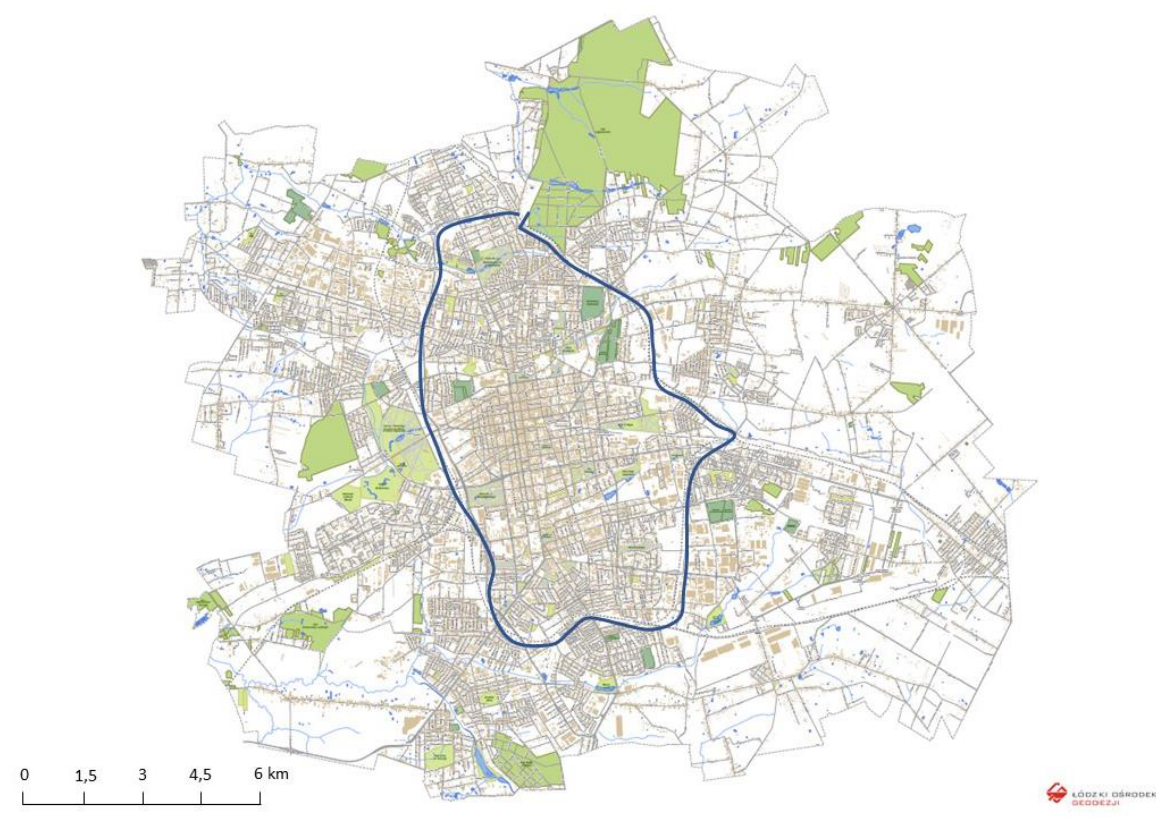
Fig. 1. Delimitation of the Łódź research area – areas limited by the Agglomeration Railway (Source: author’s own elaboration based on the INTERSIT map of Municipal Geodesy Centre of Łódź and the Strategy for the Spatial Development of Łódź